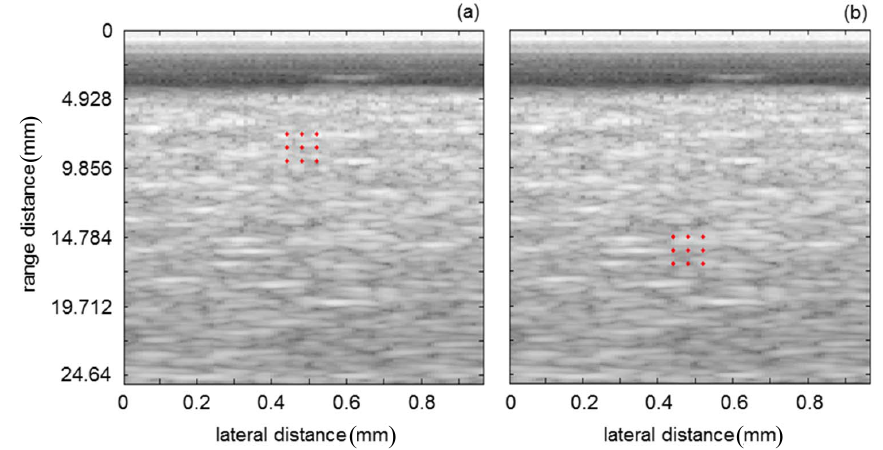
Figure 4. B-mode image of phantom. Red points are points in shallow ( a ) and deep ( b ) regions of interest to be tracked.